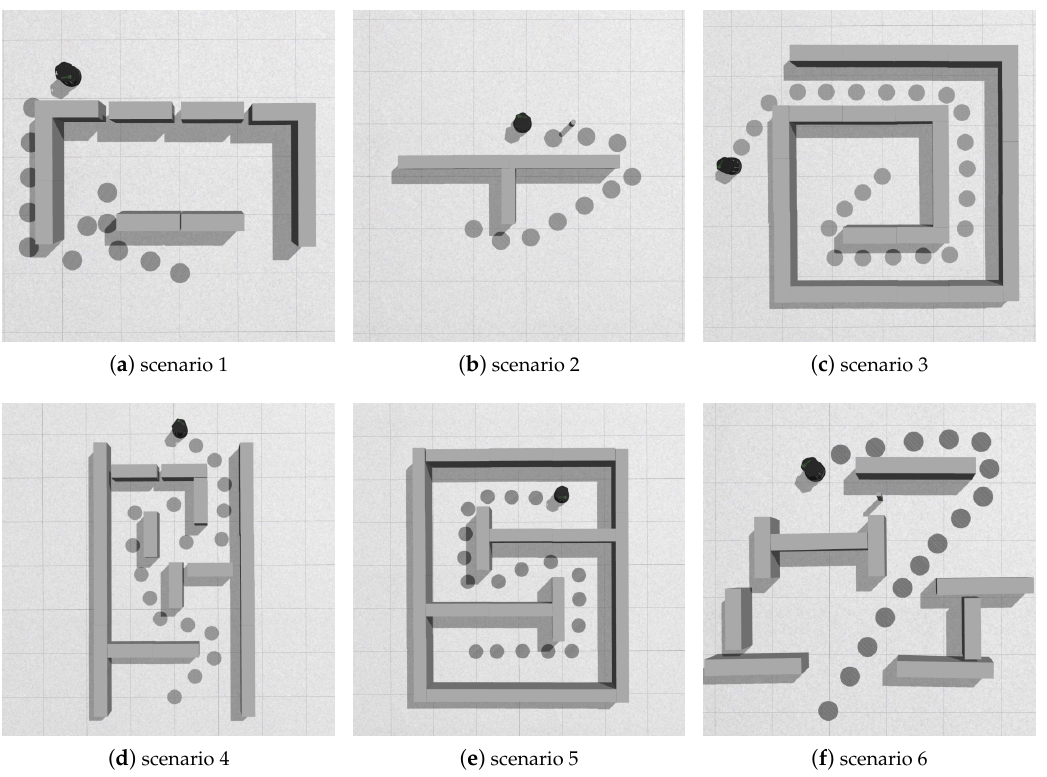
Figure 12. Examples of